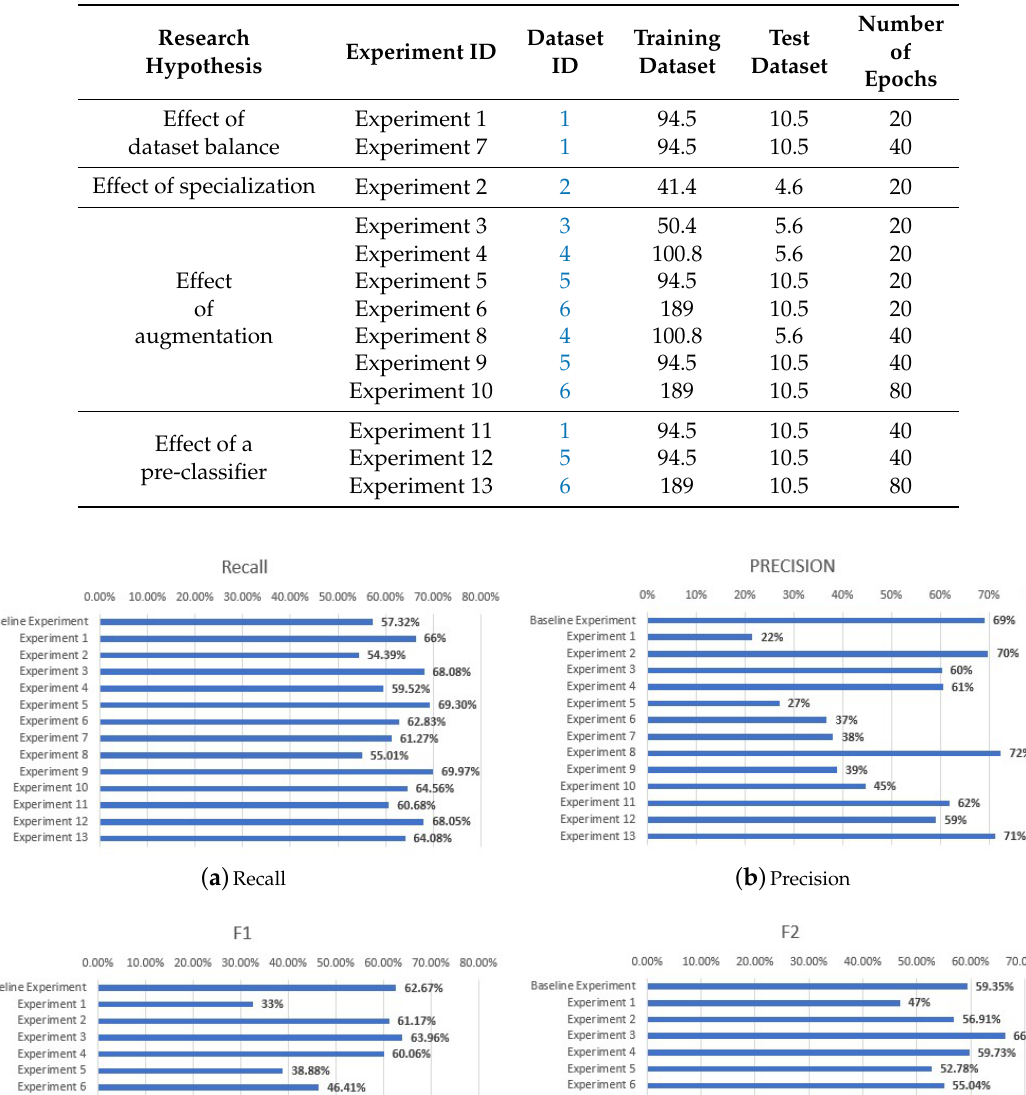
Table 8. Overview of all experiments.